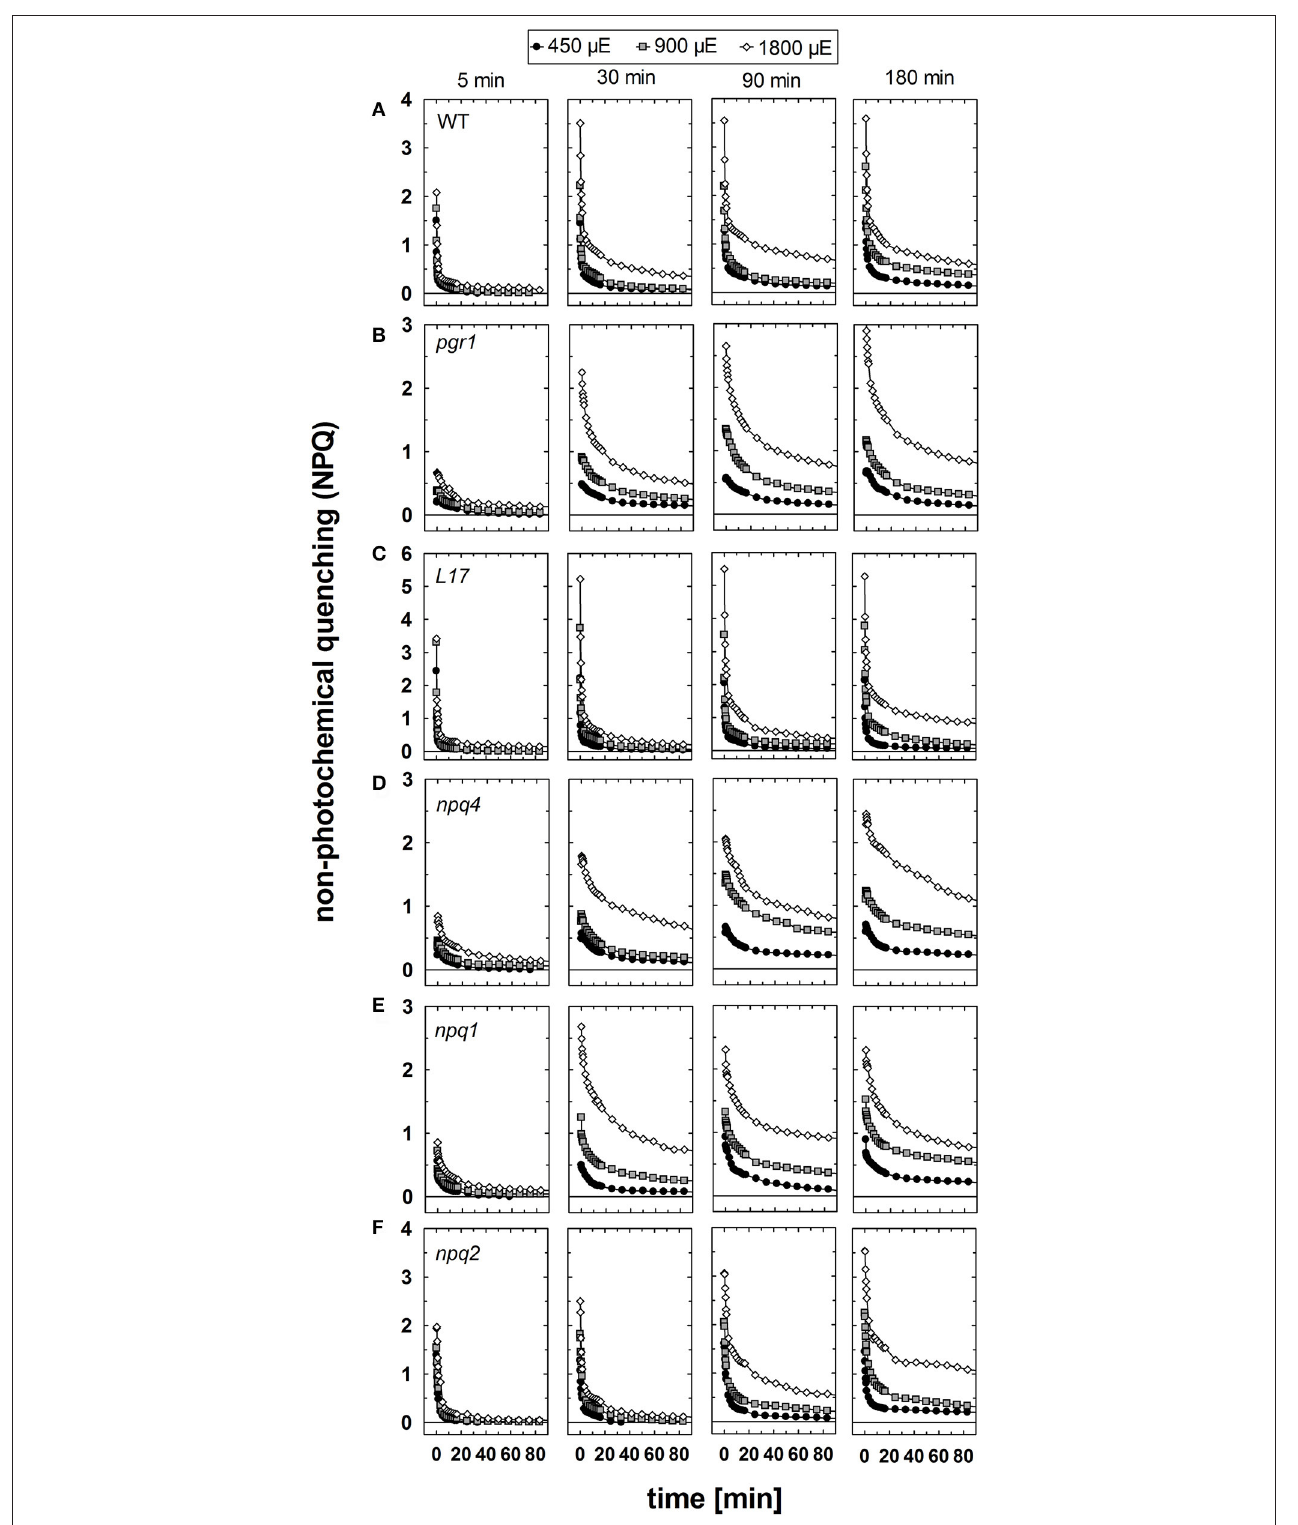
FIGURE 6 | NPQ relaxation. The dark relaxation of NPQ after pre-illumination at three different actinic light intensities (450, 900, and 1,800 µ E of white light) for 5, 30, 90, and 180min was determined for (A) WT, (B) pgr1 , (C) L17 , (D) npq4 , (E) , npq2, and (F) npq1 plants. During the whole measurements, detached leaves were placed on wet paper in a temperature-controlled cuvette (20 ◦ C) under permanent supply with ambient air. Mean values of 3–6 independent measurements are shown. For clarity, error bars, which ranged from 0.1 to 0.3 in all cases, are not shown.